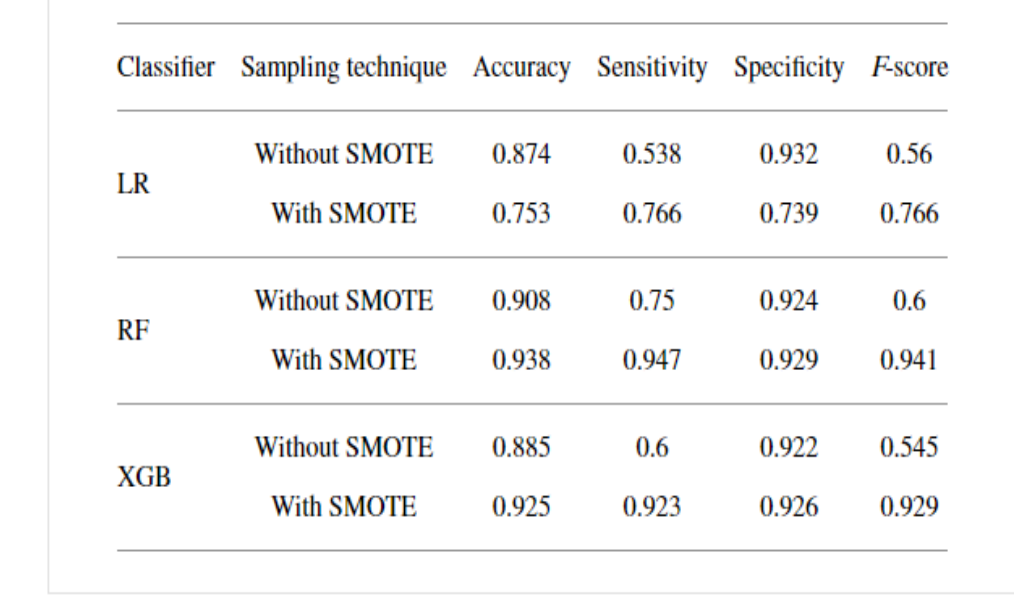
Figure 5. Table of results adapted from [22] of the study from King Faha University Hospital in Saudi Arabia, using the three machine learning models.